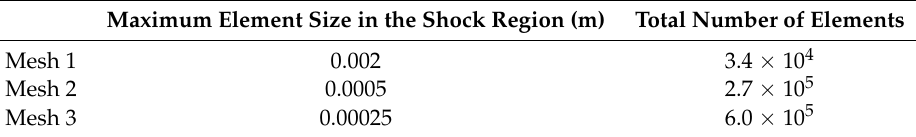
Figure 11. Comparison of “Physics Controlled” Mesh 1 and “User-defined” Mesh 2. Table 3. Meshes main